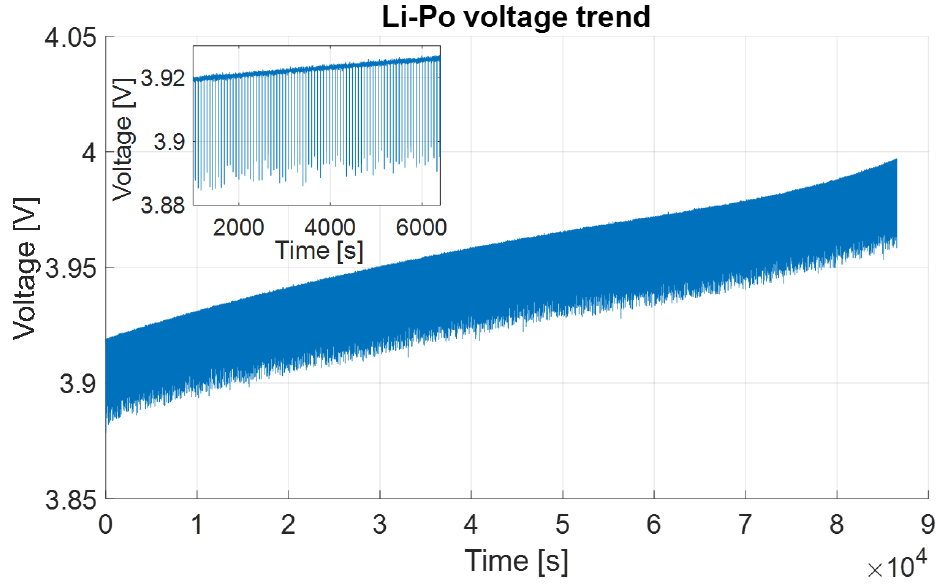
Figure 8. Li-Po voltage trend with radio transmissions every minute and ∆ T = 30 °C. The inset shows a magnified 90-min section of the